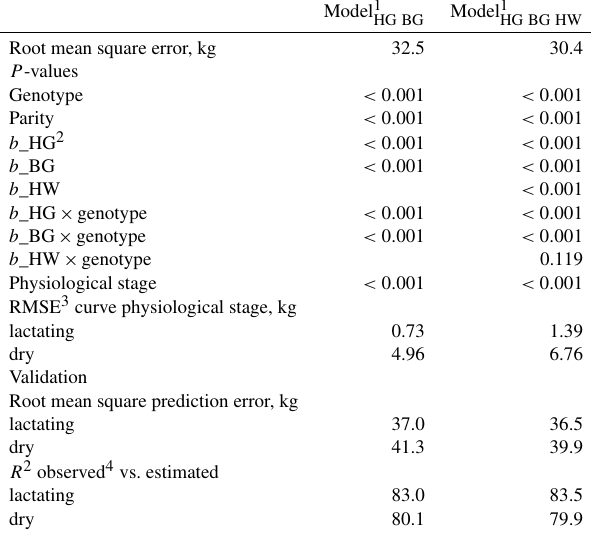
Table 5. Root mean square error (RMSE), P -values, RMSE of the curves fitted to the fixed effect of physiological stage, as well as the root mean square prediction error and the coefficient of determina- tion ( R 2 ) of the relationship between predicted and observed body